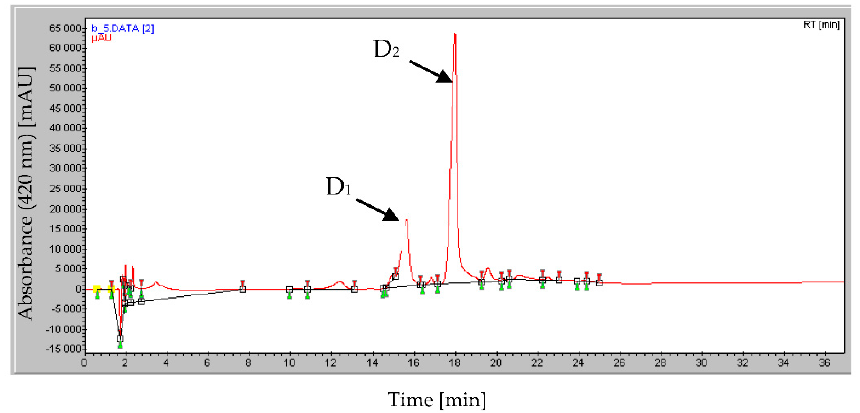
Figure 2. HPLC analysis of the fraction D bearing both antibiotic and rock phosphate-solubilizing activity. This fraction contains two main peaks, D 1 (Rf = 15.62) and D 2 (Rf = 17.99 min).